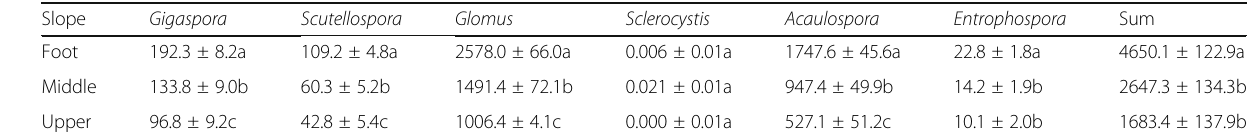
Table 5 AMF spore density (100 g − 1 of dry soil) across foot, middle, and upper slope position